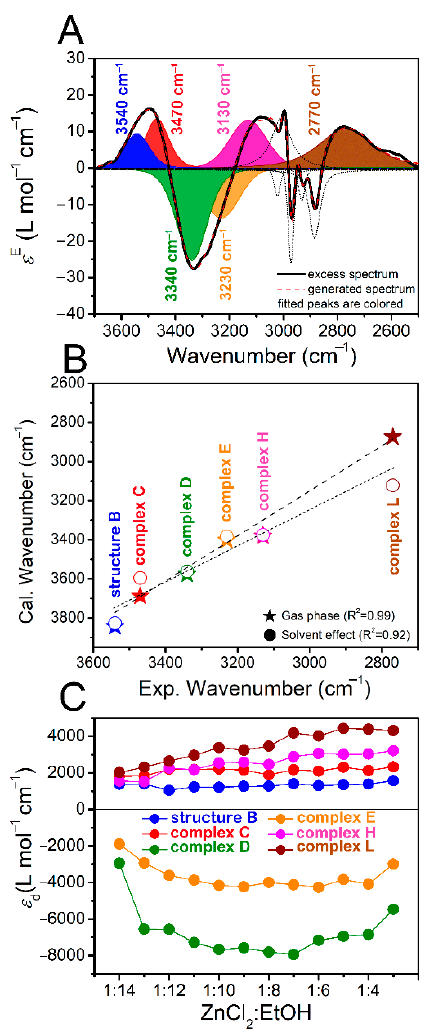
Figure 4. Deconvolution results of the excess spectrum of the ZnCl 2 -EtOH mixture in a 1:3 molar ratio ( A ), relationship between the experimental wavenumbers from the deconvoluted excess peaks and the selected theoretical results at B3LYP-D3 optimized in gas phase or under solvent effect ( B ), molar absorptivity deviation of the hydroxyl-containing deconvoluted excess peaks ( C ). Only the hydroxyl-related deconvoluted peaks are colored in ( A ).